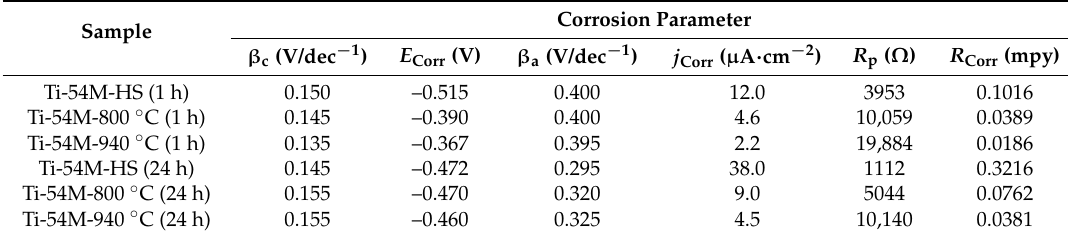
Figure 7. Cyclic potentiodynamic polarization curves obtained for ( a ) hot swaged; ( b ) annealed at 800 ◦ C; and ( c ) annealed at 940 ◦ C Ti-45M electrodes after their immersion for 24 h in 2 M HCl solutions. Table 2. Parameters obtained from the polarization curves for the different Ti-54M alloys in 2 M HCl